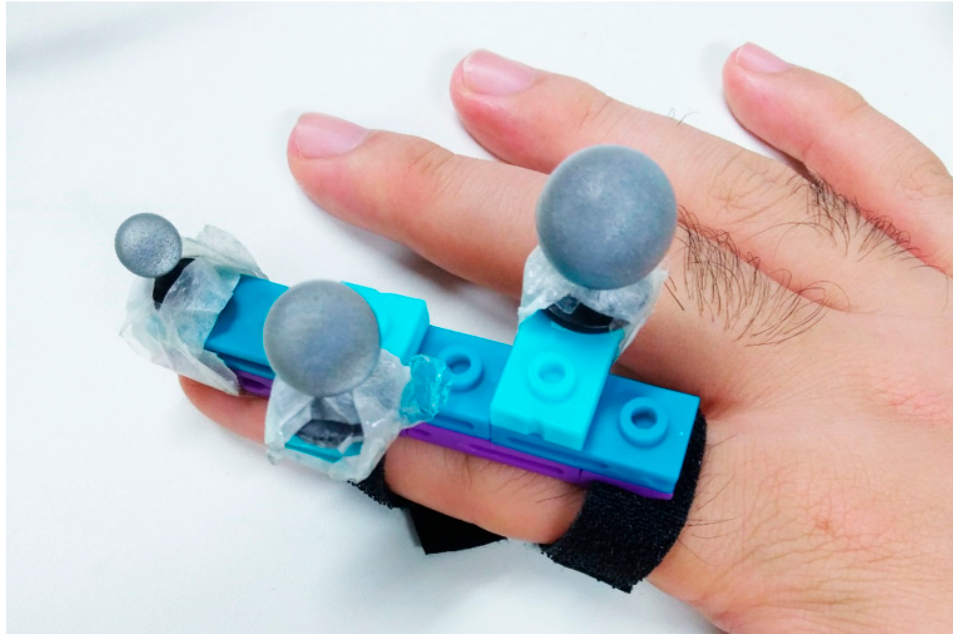
Figure 5. Fixture with marker wrapped and fixed around the finger with Velcro.